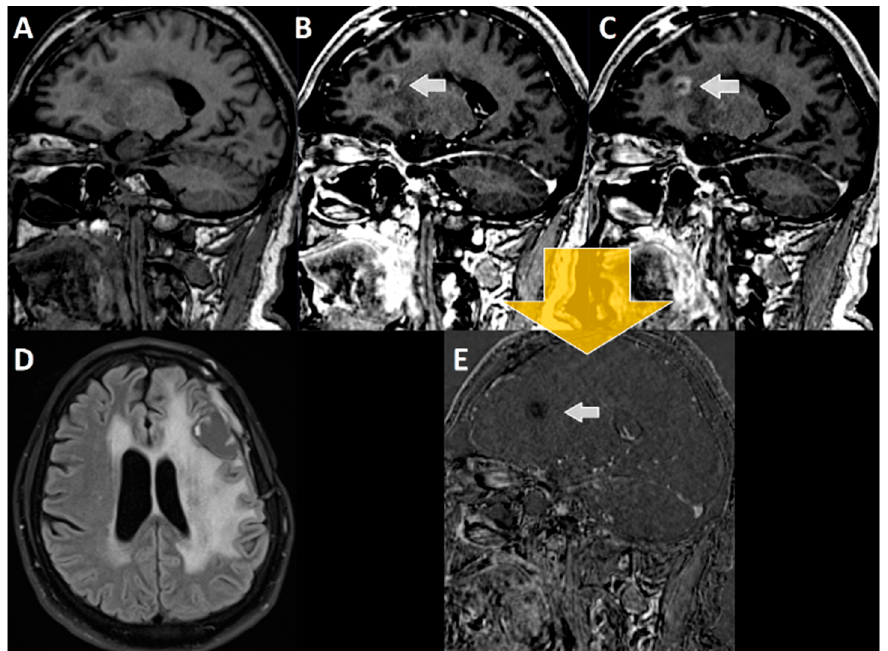
Figure 5. MRI imaging of a 66-year-old patient with glioblastoma, 21 months after resection and 18 months after combined radiochemotherapy with discontinuation of temozolomide therapy after the third cycle and 6 months after re-radiotherapy. ( A ) Non-enhanced, sagittal T1-MPRAGE; ( B ) early T1-MPRAGE 2 min after contrast administration; and ( C ) late T1-MPRAGE 20 min after contrast administration. The white arrow points towards the suspected left frontal lesion. ( D ) FLAIR imaging in transversal orientation. ( E ) The subtraction image ( B – C = E ). In the subtraction images, the lesion does not show any uptake, unlike the venous vessels (which typically, after 20 min, show a physiological wash out). The suspicious lesion thus shows a “pooling” of contrast agent and, therefore, is not suspicious for tumor recurrence, but for TRCE (which was confirmed in histopathological analyses).